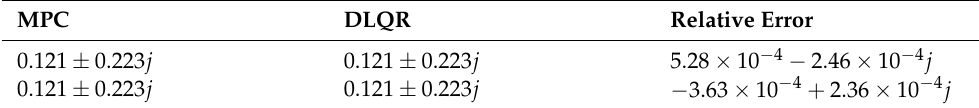
Table 8. Eigenvalues comparison between DLQR and MPC under the unconstrained